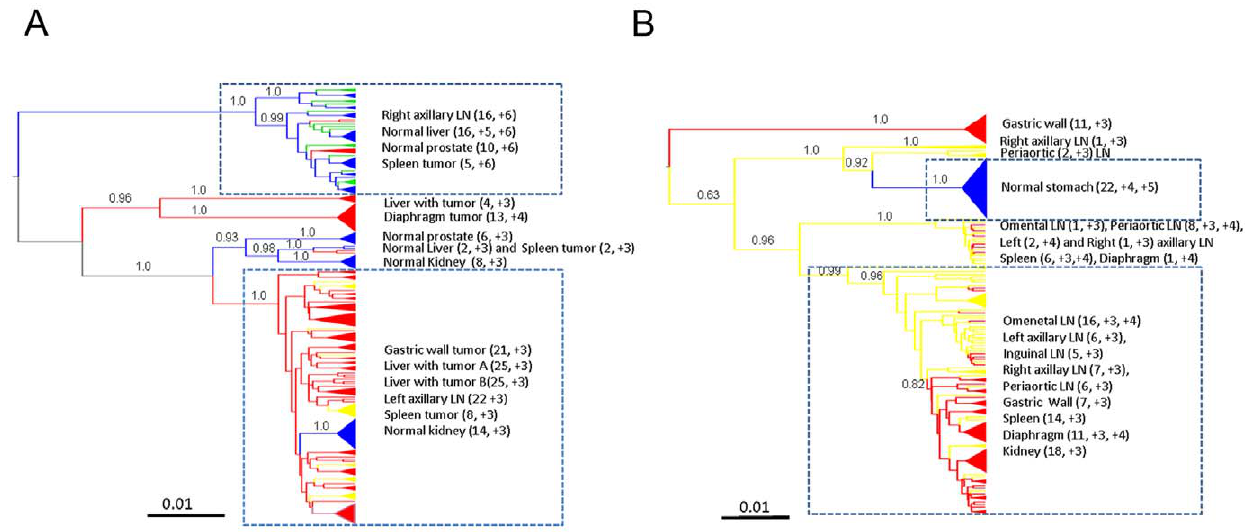
Figure 2. Phylogenetic analysis HIV-1 gp120 sequences from different tissues. Bayesian maximum clade credibility trees assuming a relaxed molecular clock and constant population size coalescent prior generated from the posterior distribution of trees less a 50% burn-in. Branch lengths are shown according to the scale bar at the bottom of each panel, in relative units of time (nucleotide substitutions per site). Posterior probabilities for major nodes are indicated. Internal branches are colored according to the maximum parsimony reconstruction of the ancestral tissue of origin: red=tumor; yellow or green=lymph node; blue=normal tissue. Posterior probability values . 80% are shown along the branches. The tissues of origin found within major clades are listed to the right with LN indicating lymph nodes. Number of sequences and V3 loop net charge within the clade for each tissue are given in parentheses. A. Subject AM. Yellow and green lineages represent viral strains from right and left axillary lymph nodes, respectively. B. Subject IV.